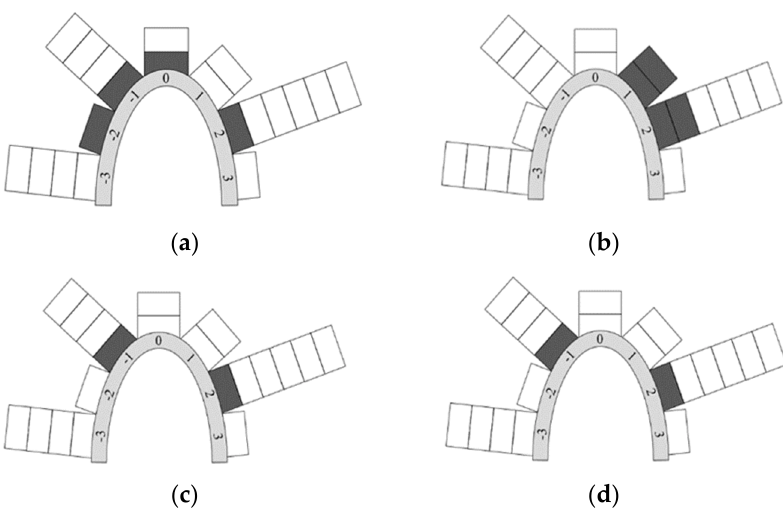
Figure 3. Overall and intra-institutional variance of distribution. Distribution patterns for statement no. 1 as discussed during the Edinburgh exercise. Grey fields in ( a ), ( b ), ( c ) and ( d ) indicate intra-institutional distribution of participants.